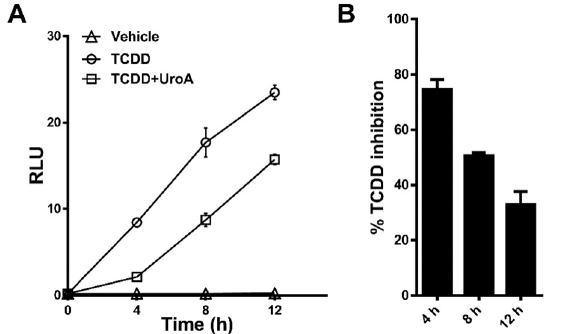
Figure 7. UroA is capable of antagonizing TCDD transcriptional activity up to 12 h. ( A ) HepG2 (40/6) cells were treated for 4, 8, or 12 h with vehicle, 10 nM TCDD and 10 µM UroA as indicated, followed by luciferase reported assay. ( B ) Time-dependent percent inhibition of TCDD-induced luciferase activity by UroA treatment.